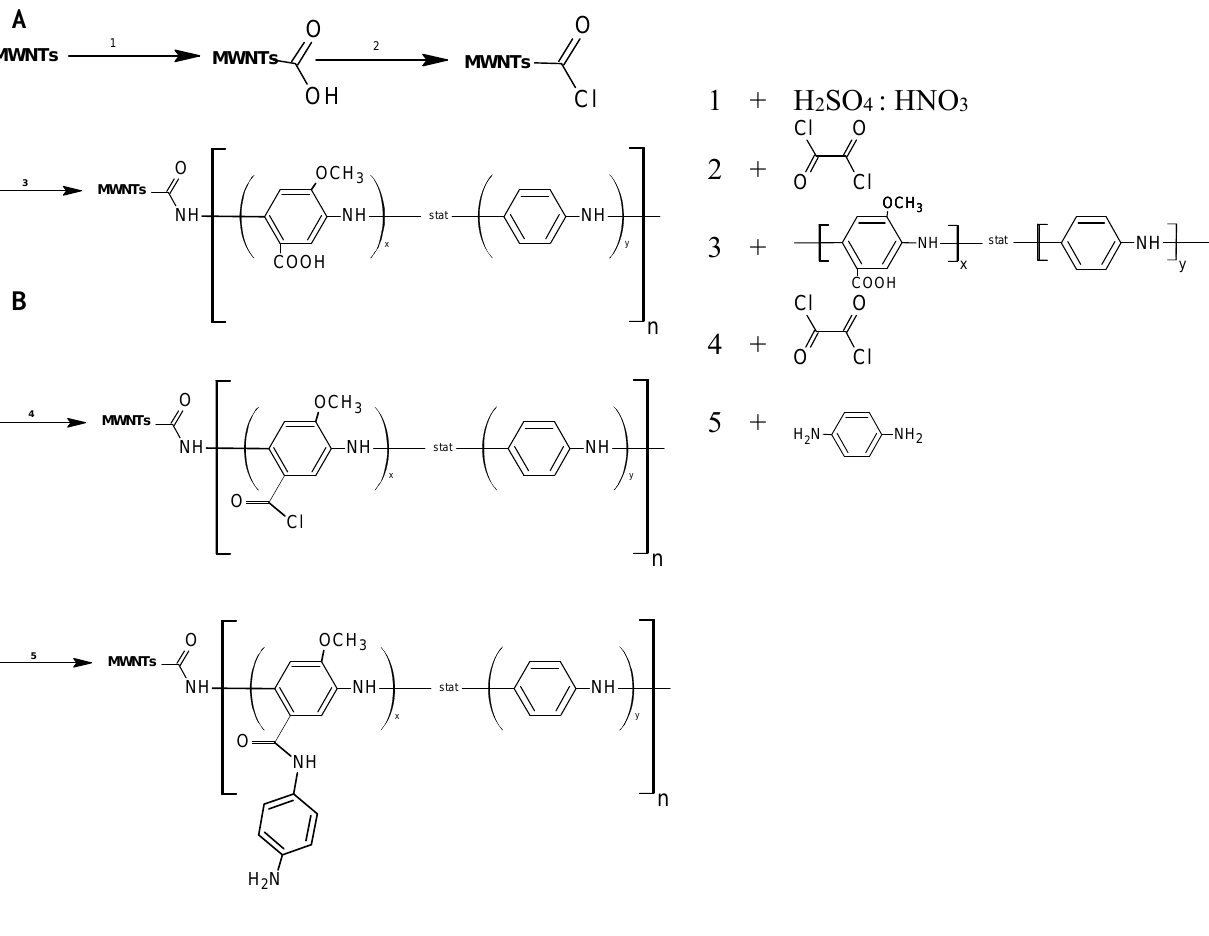
Figure 1. Schematic pathway for covalent coupling of poly(3-amino-4-methoxybenzoic acid-co-aniline) (P(AMB-A)) to polymer-multiwalled carbon nanotubes (MWCNTs) ( A ) and functionalization of P(AMB-A) with p -phenylenediamine (PDA) ( B